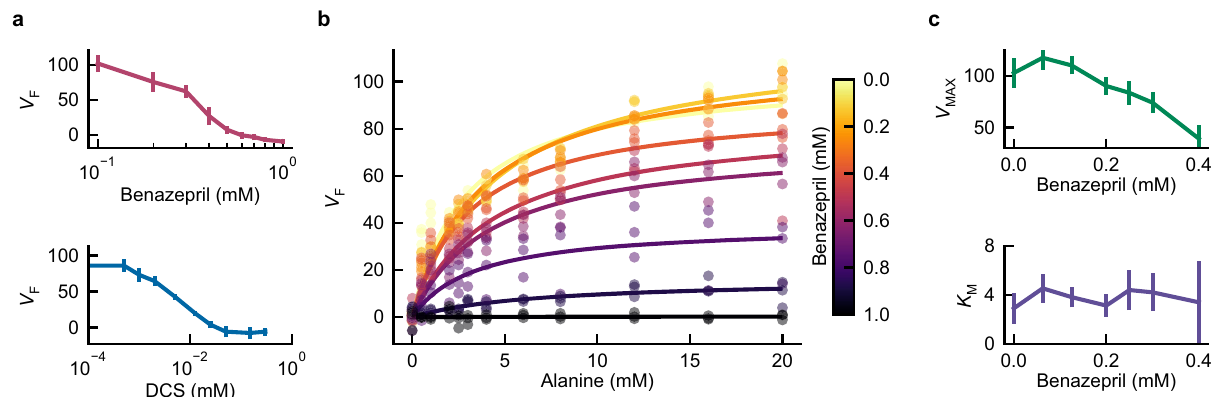
Fig. 5 Benazepril inhibits Mtb Alr in vitro. His-tagged Mtb Alr was puri fi ed and incubated with the indicated drug concentrations. Alr activity, V F , was assayed using a coupled reaction yielding NADH. a Inhibition curves for benazepril and DCS. Data is presented as the man and CI 95 of three independent assays. b In vitro kinetics of Alr varying both inhibitor and substrate. At least three individual measurements are plotted for each pair of concentrations. Lines indicate best- fi t Michaelis – Menten curves for each tested benazepril concentration. c Best- fi t values of Michaelis – Menten parameters as a function of benazepril concentration. Data is presented as the mean and CI 95 for best- fi t parameter values, as estimated using Student ’ s t-distribution. Source data are provided as a Source Data fi